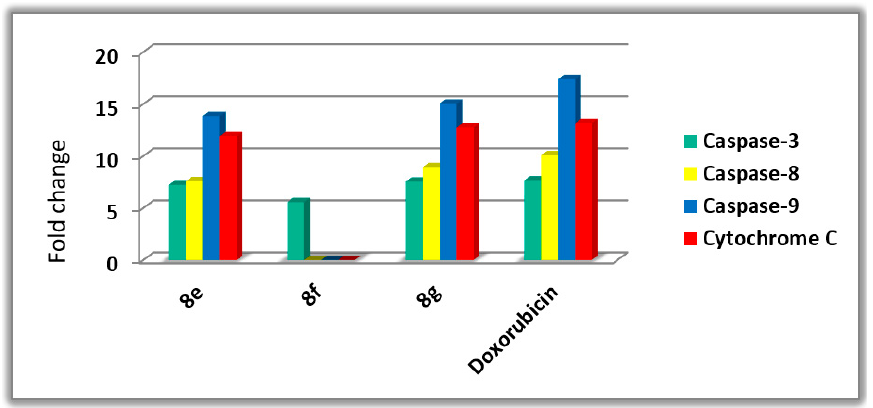
Figure 4. Effects of compounds 8e , 8f , and 8g , and doxorubicin on active Caspases 3, 8, 9, and Cytochrome C in MCF-7 breast cancer cell line.